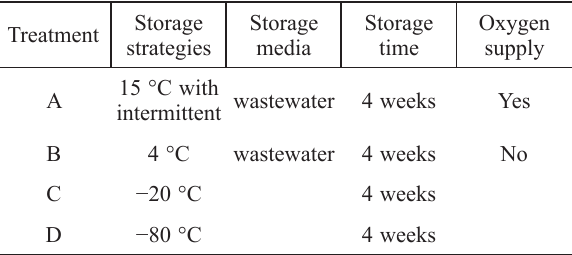
Table 2 – Different storage strategies of aerobic